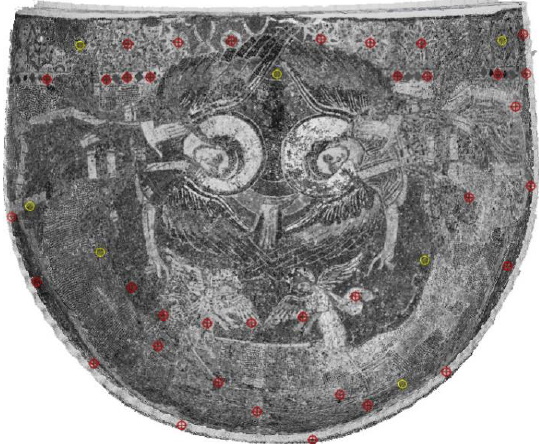
Figure 4 Survey point network over the mosaic. In yellow, CPs used as constraints, in red, CPs used as check points only